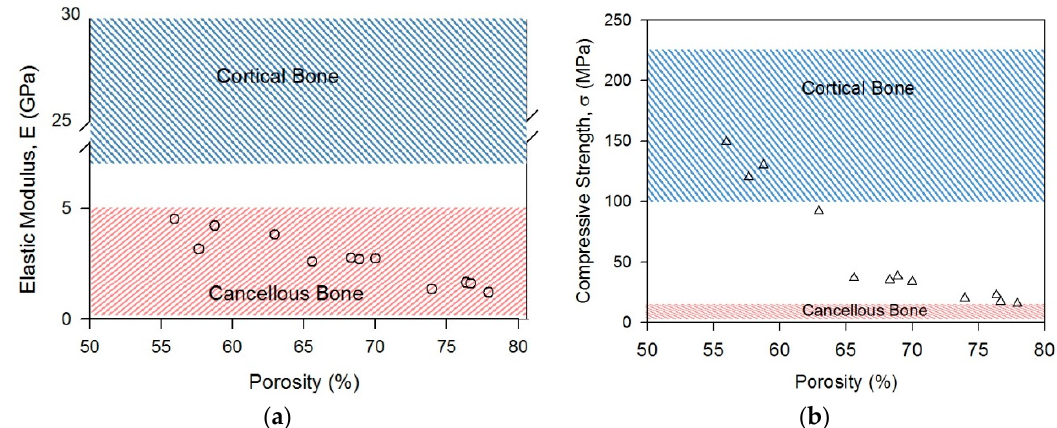
Figure 8. Mechanical properties changes of Ti foams with different porosities: ( a ) elastic modulus, ( b ) compressive strength.